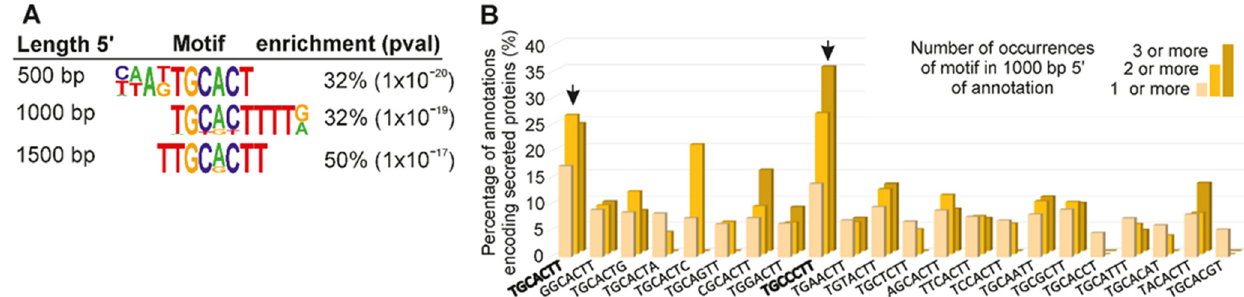
Figure 4. Identification of a promoter motif associated with DG effector genes in M. incognita . ( A ) Selected similar motifs enriched in 500, 1000, or 1500 bp promoter regions of M. incognita. DG effector genes compared to a set of non-effectors. A core motif derived from these predictions is TGCACTT. ( B ) The proportion of annotations that encode secreted proteins is shown for those that contain one (yellow), two (orange), or three (dark orange) copies of each 1 bp mismatch variant of TGCACTT.